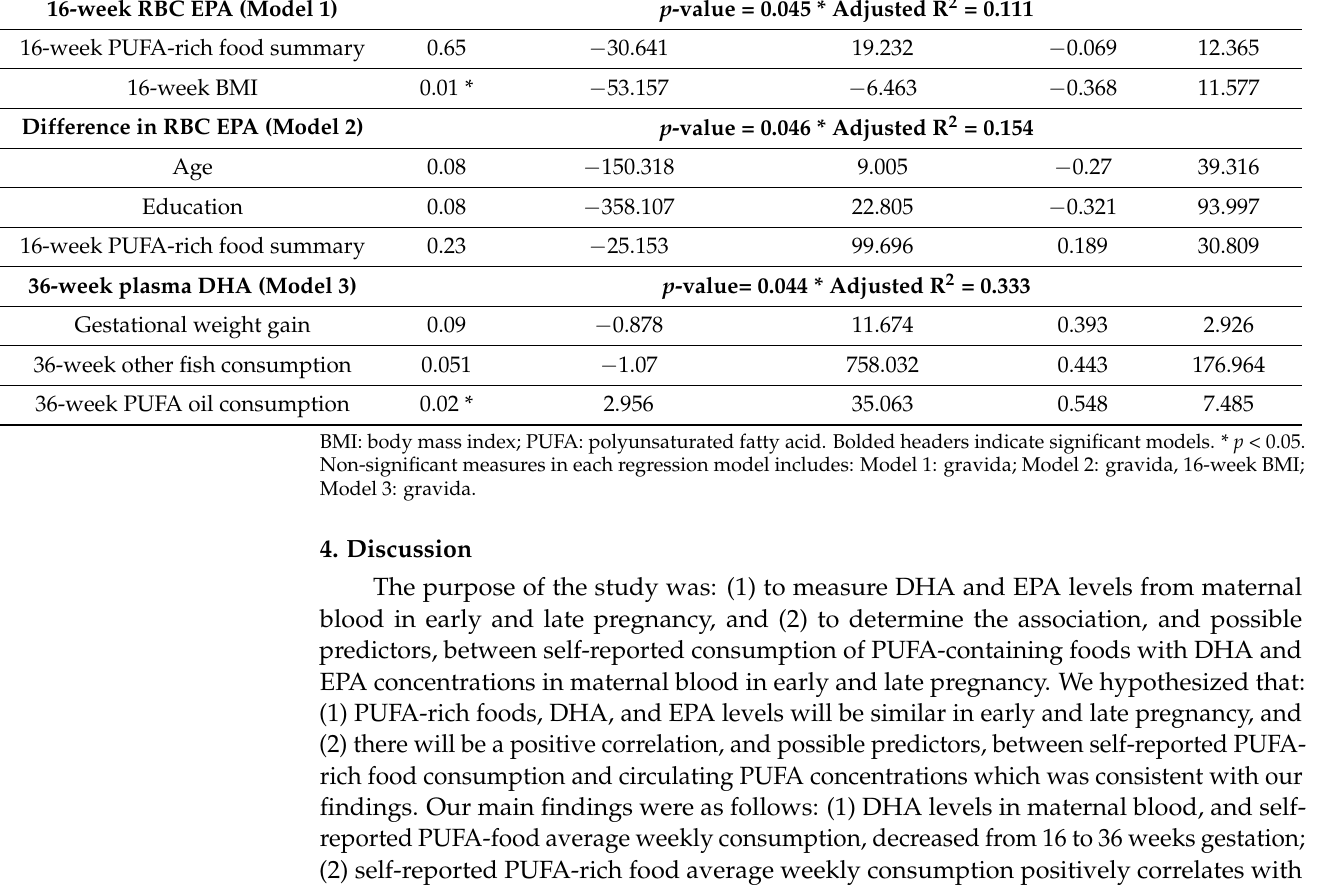
Table 5. Regression models to predict DHA and EPA levels in maternal blood. p -Value 95% CI Lower Bound 95% CI Upper Bound Beta Value STD